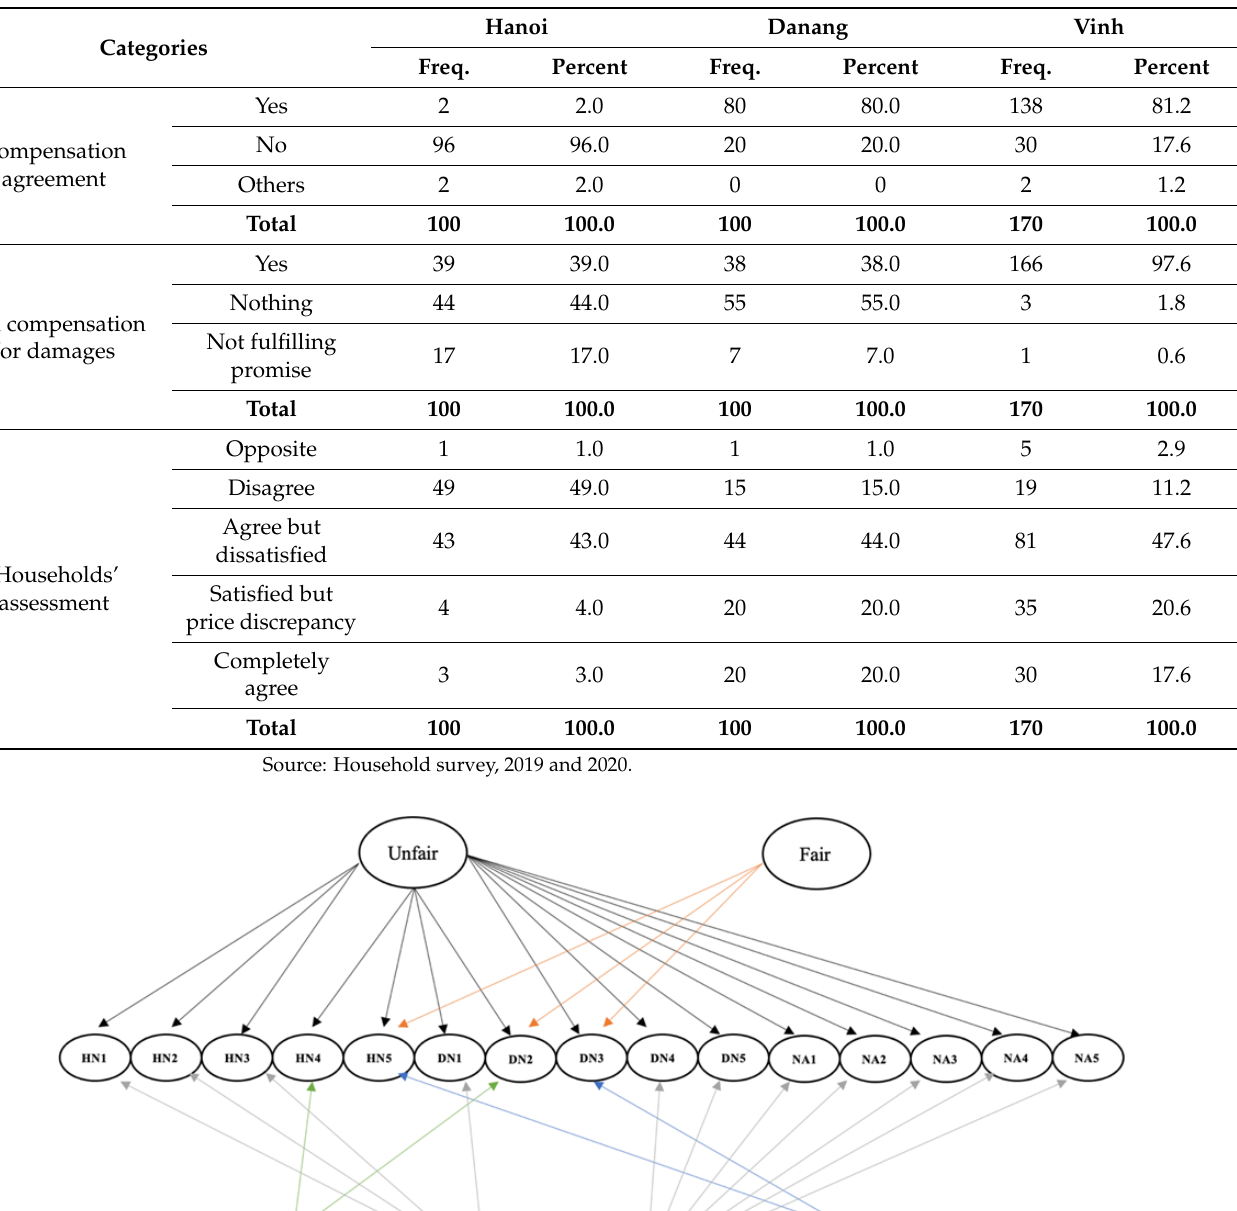
Table 3. Compensation agreement implementation and household satisfaction.